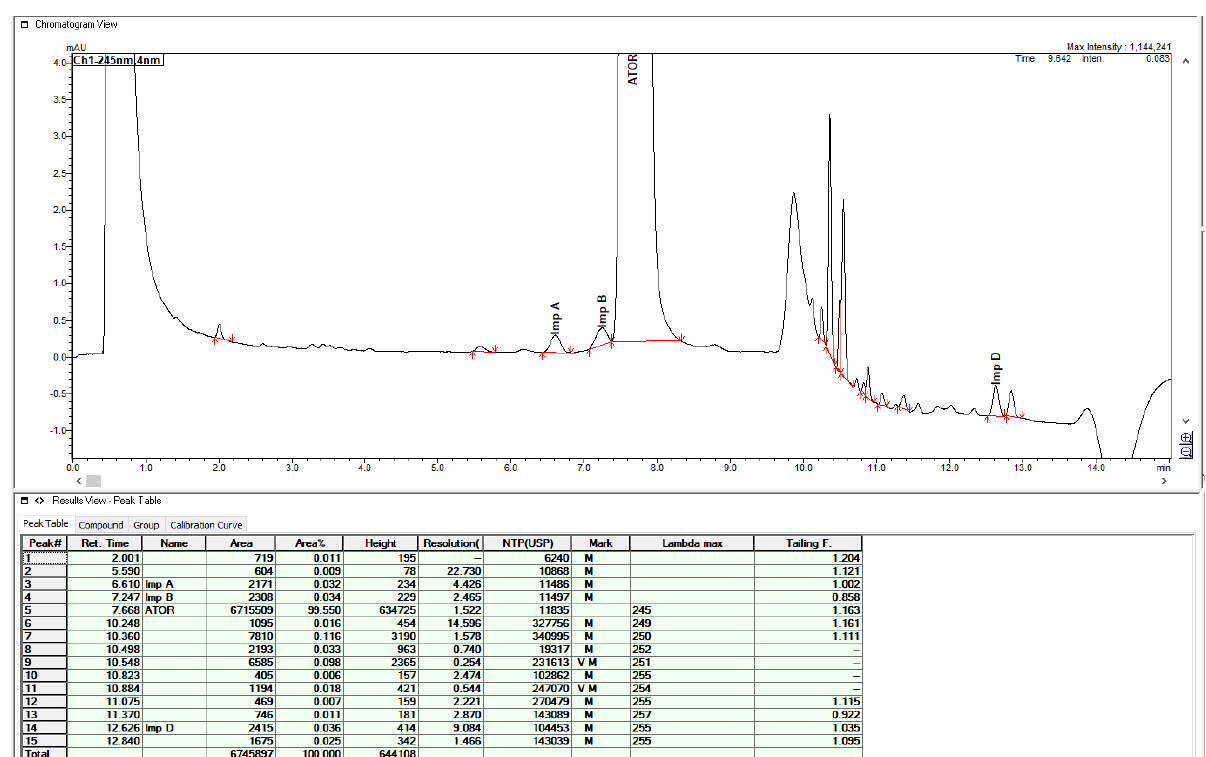
Figure 4. Chromatogram of sample solution prepared of atorvastatin tablets with a concentration of about 1 mg atorvas- tatin/mL, full scale view at the top and expanded view at the bottom.